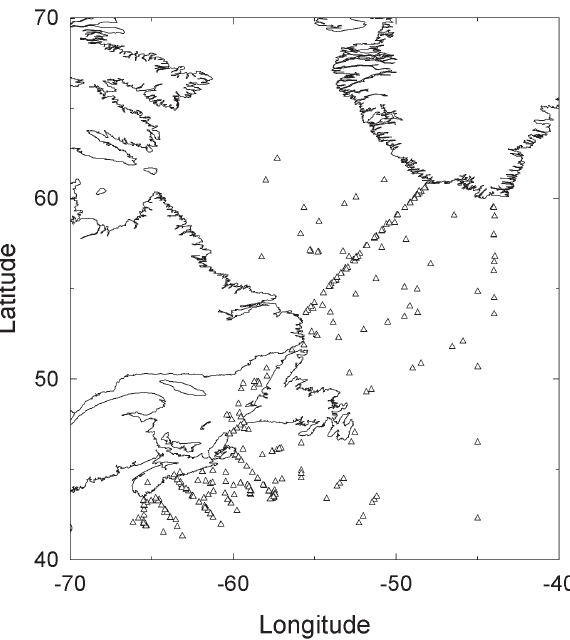
F IG . 1. – Map showing stations sampled during 15 cruises of the Scotian Shelf and Labrador